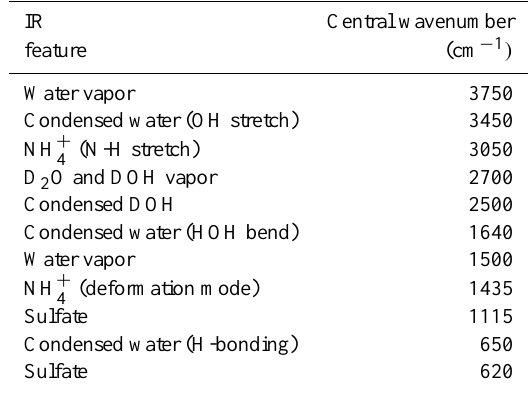
Table 2. List of IR features visible in the FTIR spectra shown in this work and corresponding central